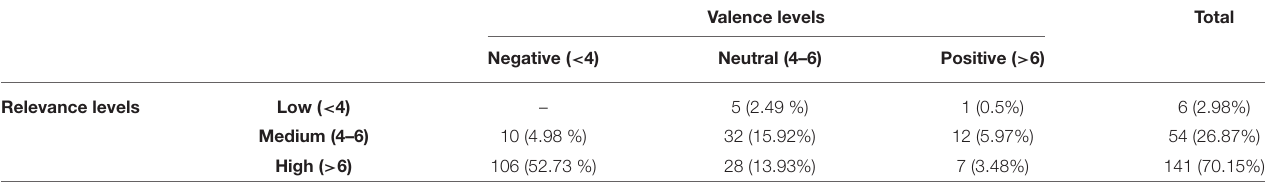
TABLE 1 | Summary of images distribution (share) according to relevance and valence ratings.